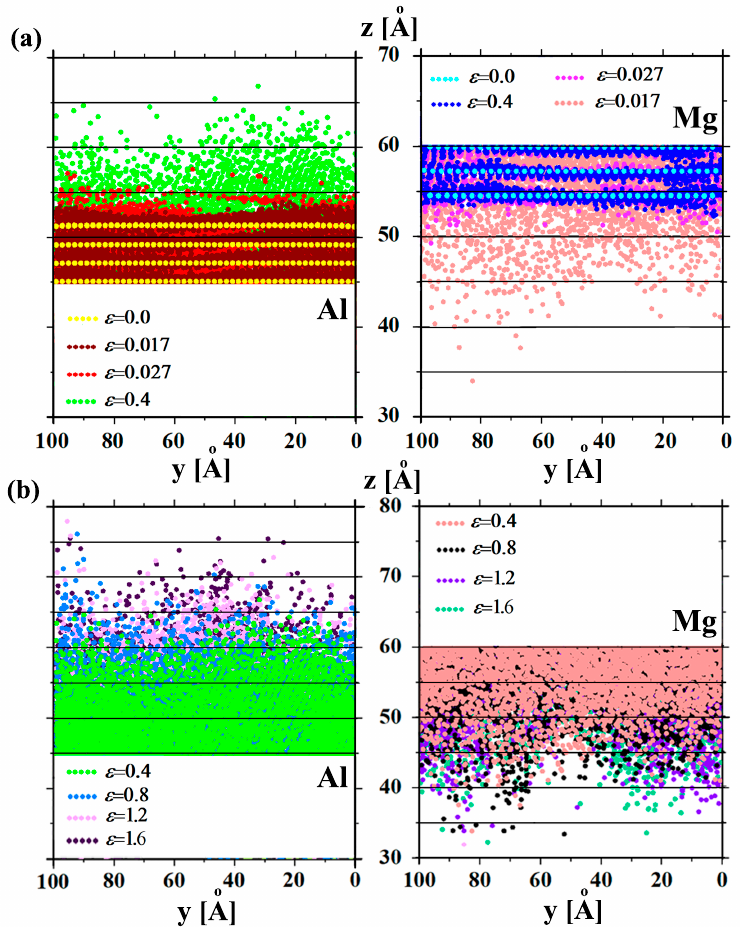
Figure 3. Changes of the atomic positions through Al–Mg interface: ( a ) for 0.0 < ε xy < 0.4 and ( b ) for 0.4 < ε xy < 1.6. Different colors correspond to different deformation stages. Only part of the sample is presented.